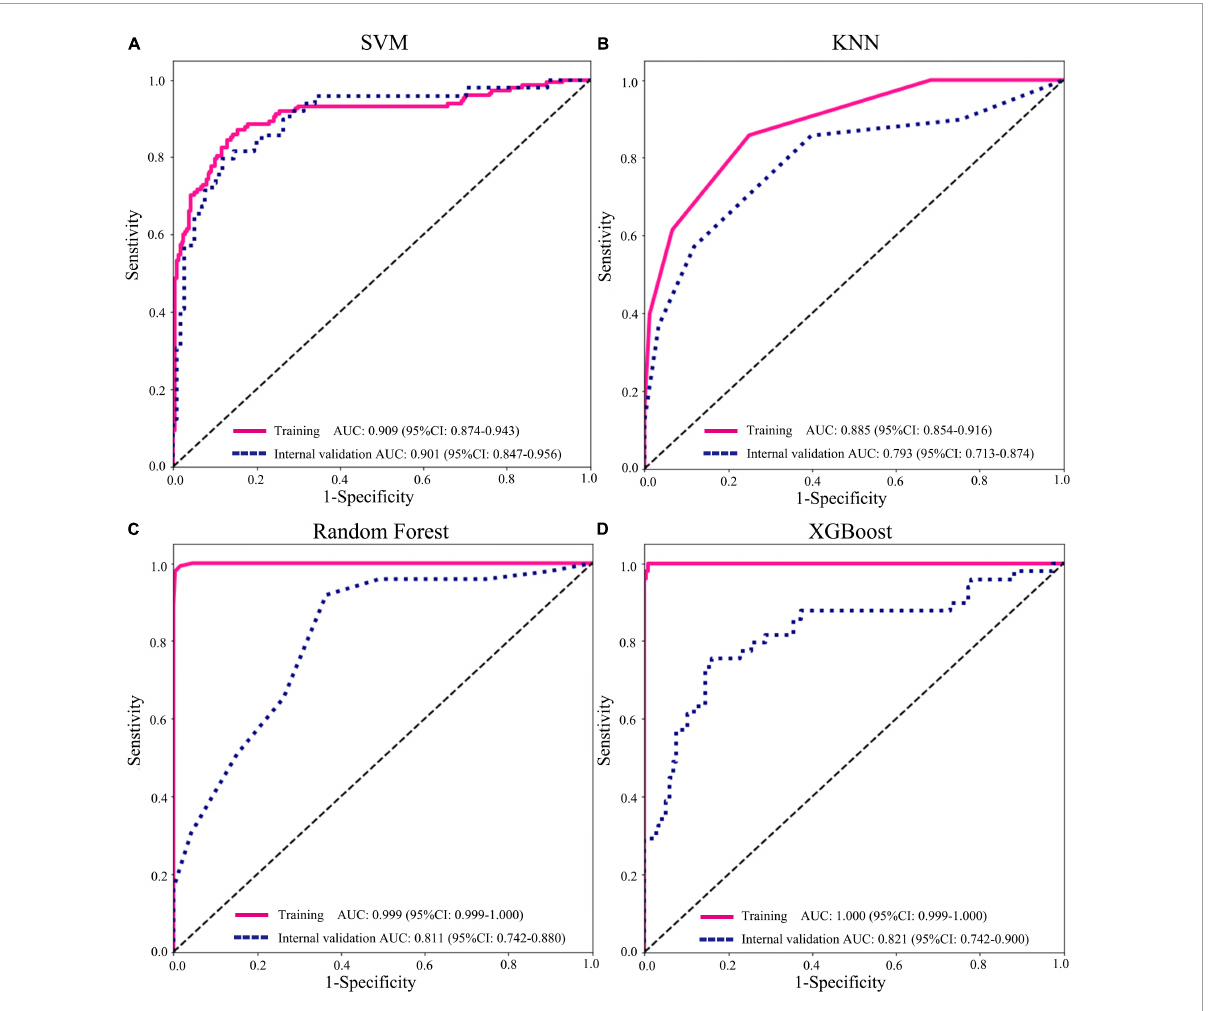
FIGURE5 Performance of different machine learning classifications based on radiomics + deep transfer learning (Resnet152) + clinical features in the training and internal validation cohorts. (A) support vector machine (SVM); (B) K-nearest neighbor (KNN); (C) random decision forests; and (D)